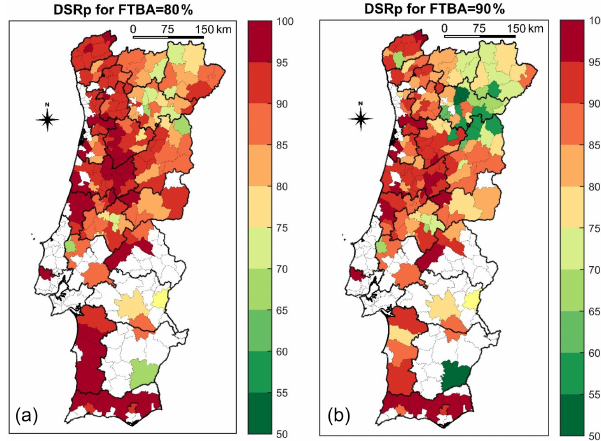
Figure 3. Scatterplot of the decimal logarithm of the accumulated burnt area (Log(accumulatedBA)) vs DSR percentile (DSRp), con- sidering the fires with an area larger than 100ha that occurred be- tween 15 May and 31 October during the period 2001–2019. The blue circles represent each wildfire, with respective accumulated BA, after being sorted by the assigned DSRp. Best fit (red line), respective equation, R 2 and p value are also presented.